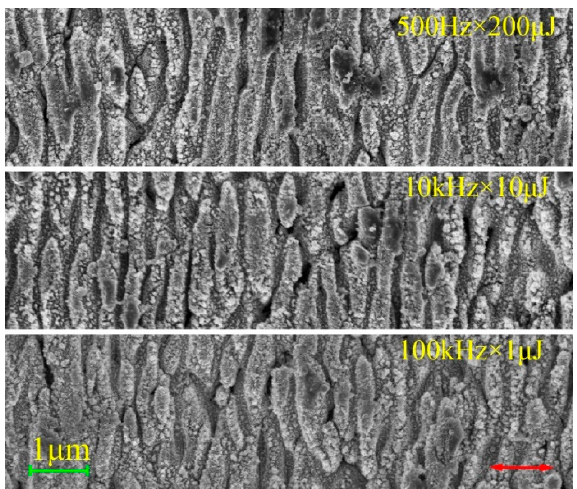
Figure 9. SEM photographs of fs laser-irradiated regions under the interaction of pulse energy and repetition rate. The scanning speed is 1 mm/s.